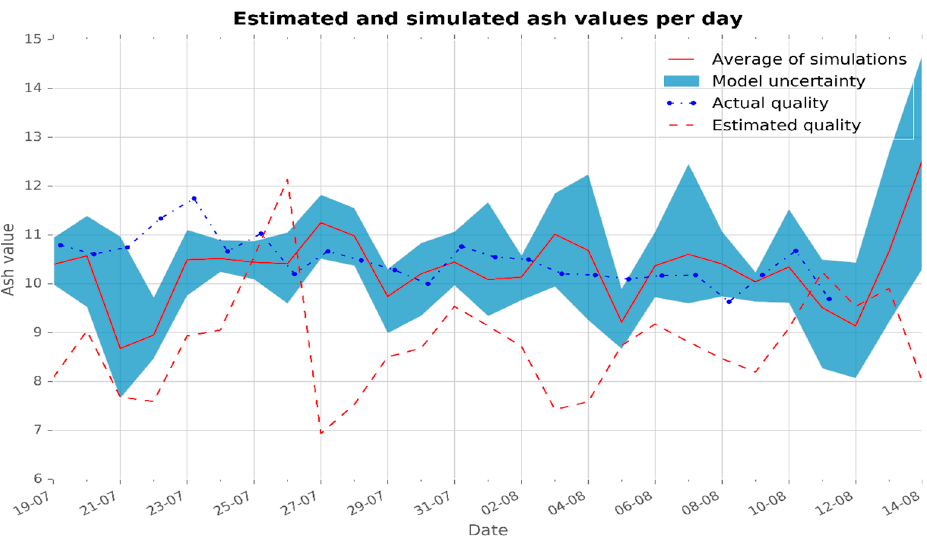
Figure 16. Daily ash values per day, case Profen.